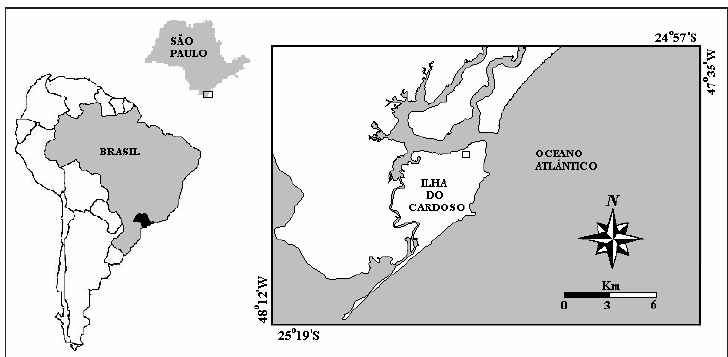
Figura 1. Localização da área